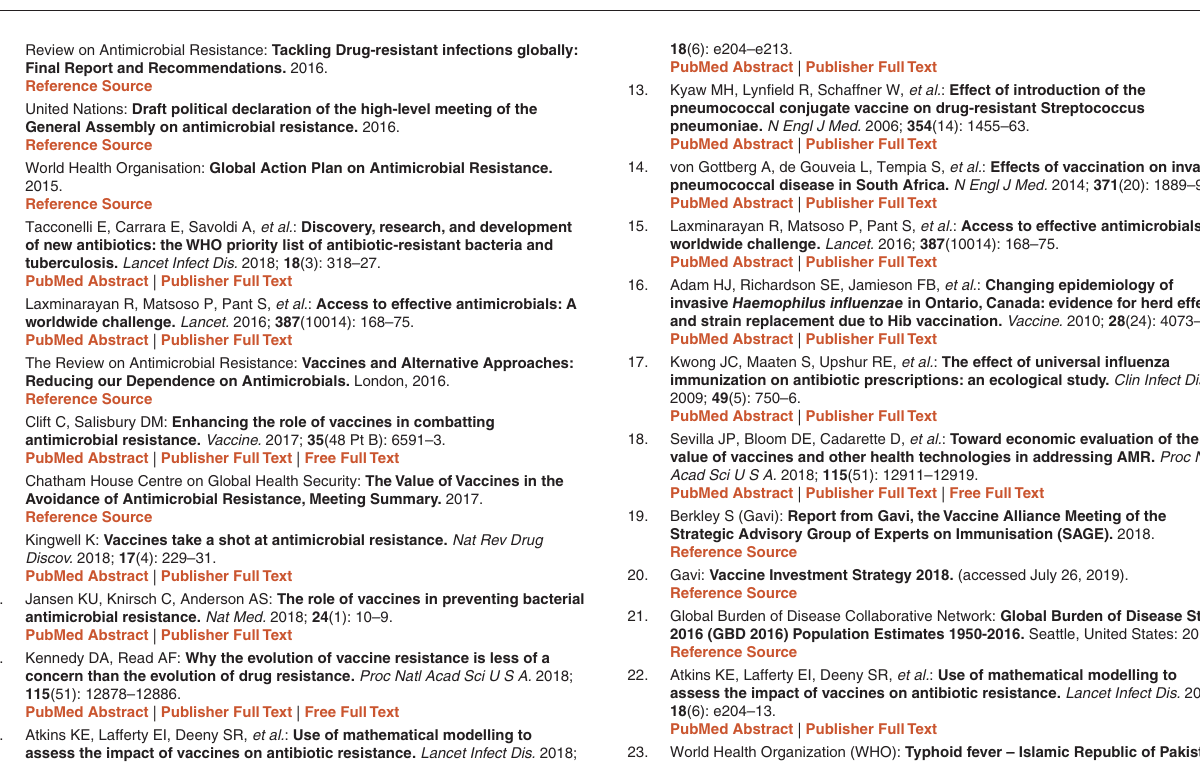
Figshare: AMR GAVI VIS Extended data. https://doi.org/10.6084/ m9.figshare.9232115